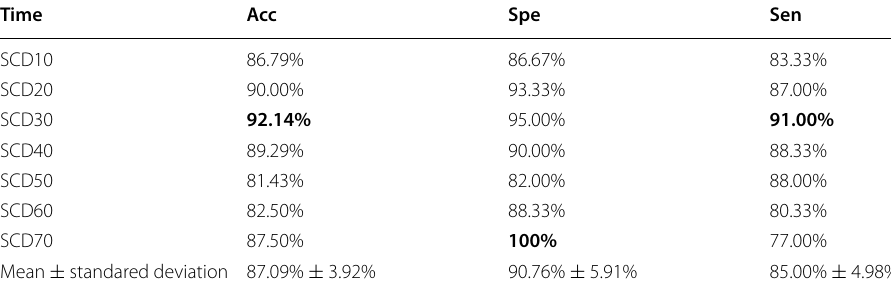
Table 3 Classification accuracy of feature S v 70 min before SCD Time